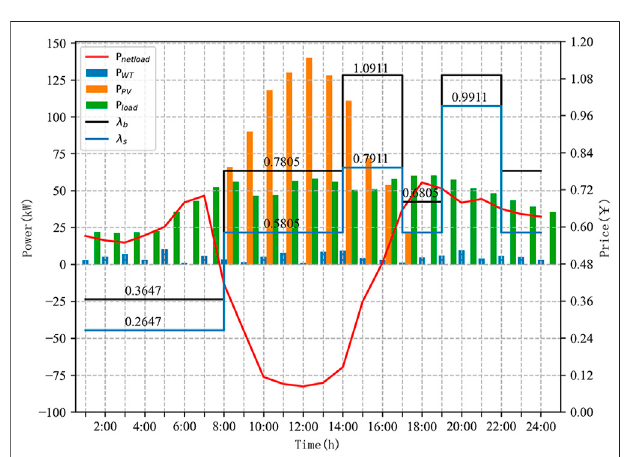
FIGURE 3 | Flow chart of RT optimal scheduling.